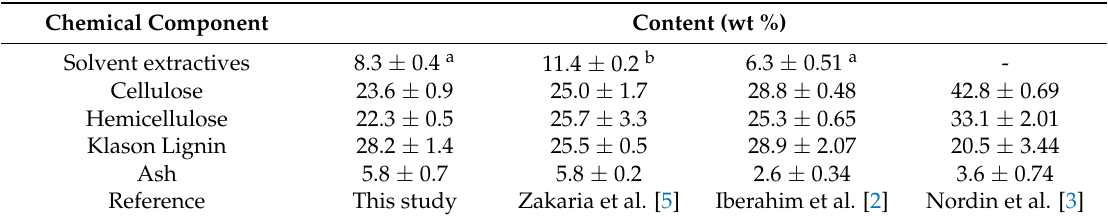
Table 1. Chemical composition of OPMF used in this study in comparison to previous